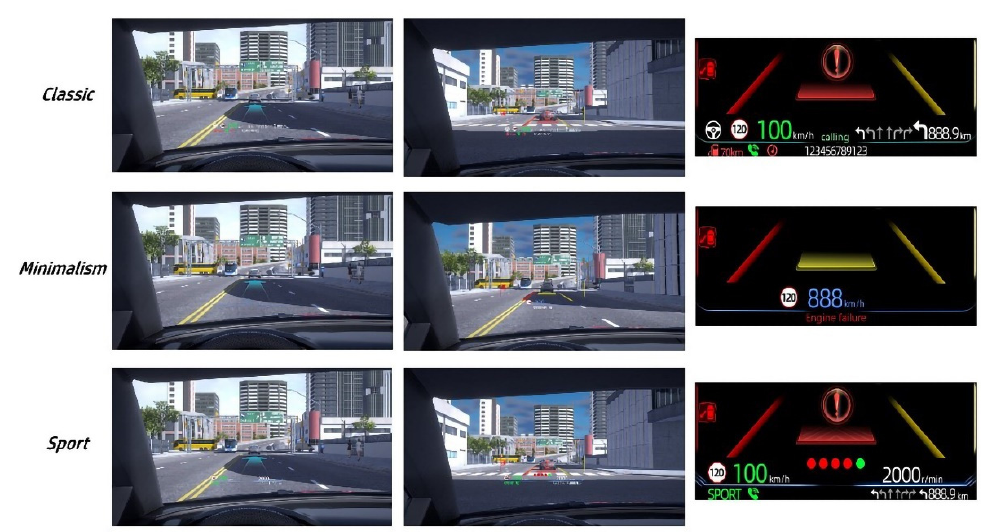
Figure 3. HUD interface design scheme 2. Scheme 2 adopts hollow navigation arrows, which en- hance the integration of AR icons and the real environment and avoid visual obstructions to road conditions. Cyclic annular warning icons are designed for the WSP and FCWS. To be specific, icons in sport mode are designed to be more dynamic and powerful.